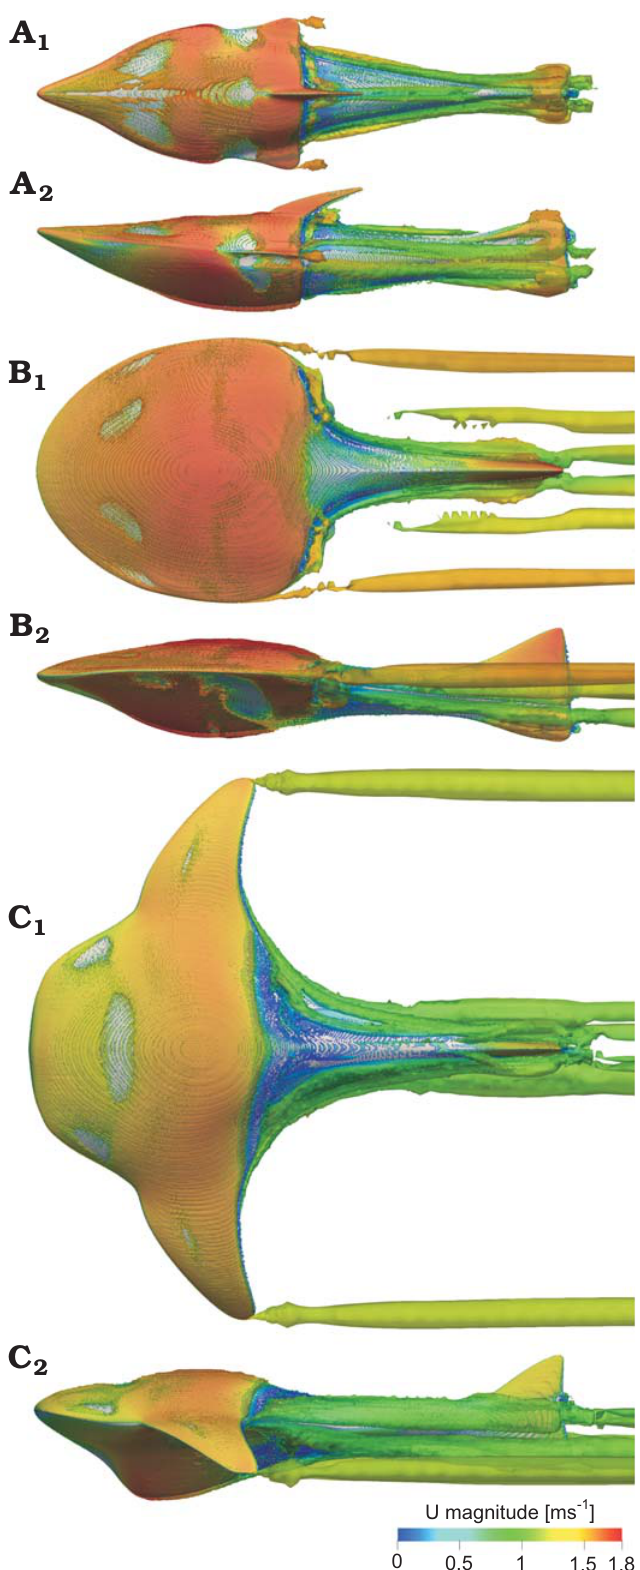
Fig. 4. Vorticity patterns using Q-criterion for 0 angles of attack and flow velocity 1.5 ms -1 in Errivaspis ( A ), Guerichosteus ( B ), and Tartuoste- us ( C ). Models displayed in left lateral (A Iso-vorticity surface is colored by the magnitude of